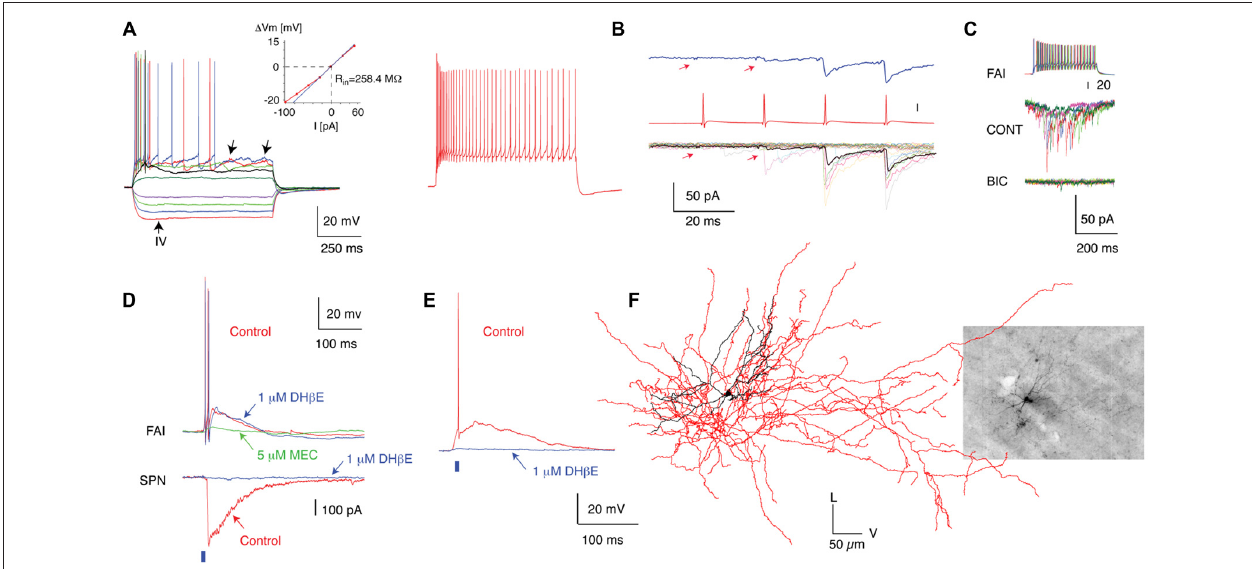
FIGURE 3 | Anatomical, electrophysiological and circuit properties of FAI. (A) Membrane potential responses of a typical FAI to injected current pulses. Note the pronounced spike frequency adaptation and irregular membrane potential fluctuations (left panel, arrows). Inset shows the current–voltage relationship of this neuron. (B) IPSC trains in an SPN elicited by trains of presynaptic action potentials in a FAI. (C) IPSCs in SPNs are blocked by a GABA A receptor antagonist (bicuculline, 10 µ M). (D) Simultaneous recording from an FAI and an SPN. Optogenetic activation of cholinergic inputs (2-ms pulse of blue light, blue bar) elicited a large-amplitude IPSC in the SPN (bottom) and an EPSP giving rise to action potentials in the FAI (top). Note the diversity of pharmacological blockade in FAI in (D,E) . While application of DHbE (1 µ M) block the IPSC in SPNs and the nicotinic EPSP in some FAI (E) it has no effect on other FAI ( D ; upper traces). In this case the nicotinic EPSP is blocked by MEC (5 µ M). (F) 3D reconstruction of a FAI filled with biocytin after recording (Inset). The soma and dendritic fields are represented in black and the axon in red in the reconstructed image. Figure adapted from Faust et al.